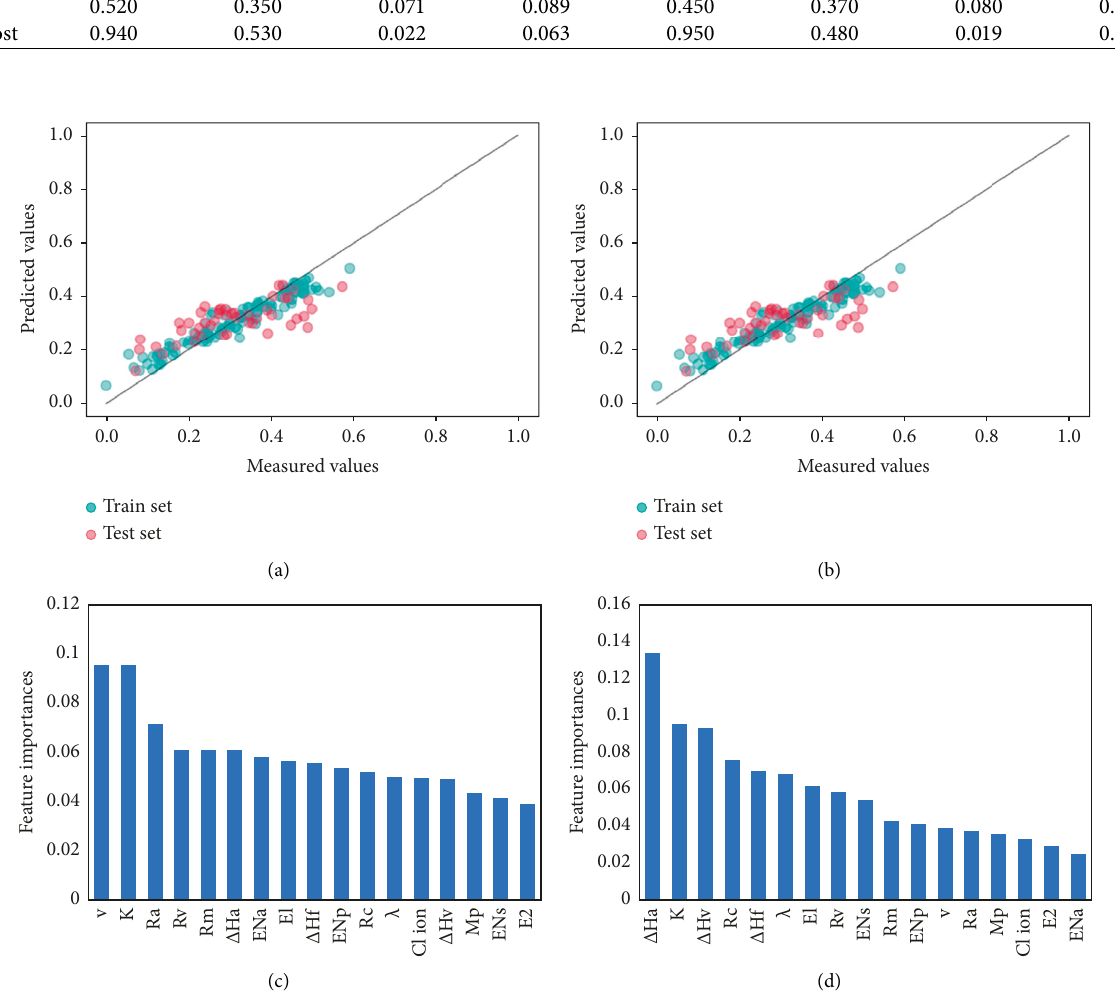
Figure 3: Predictive performance for corrosion potential and corrosion current using the RF model and corresponding characteristic